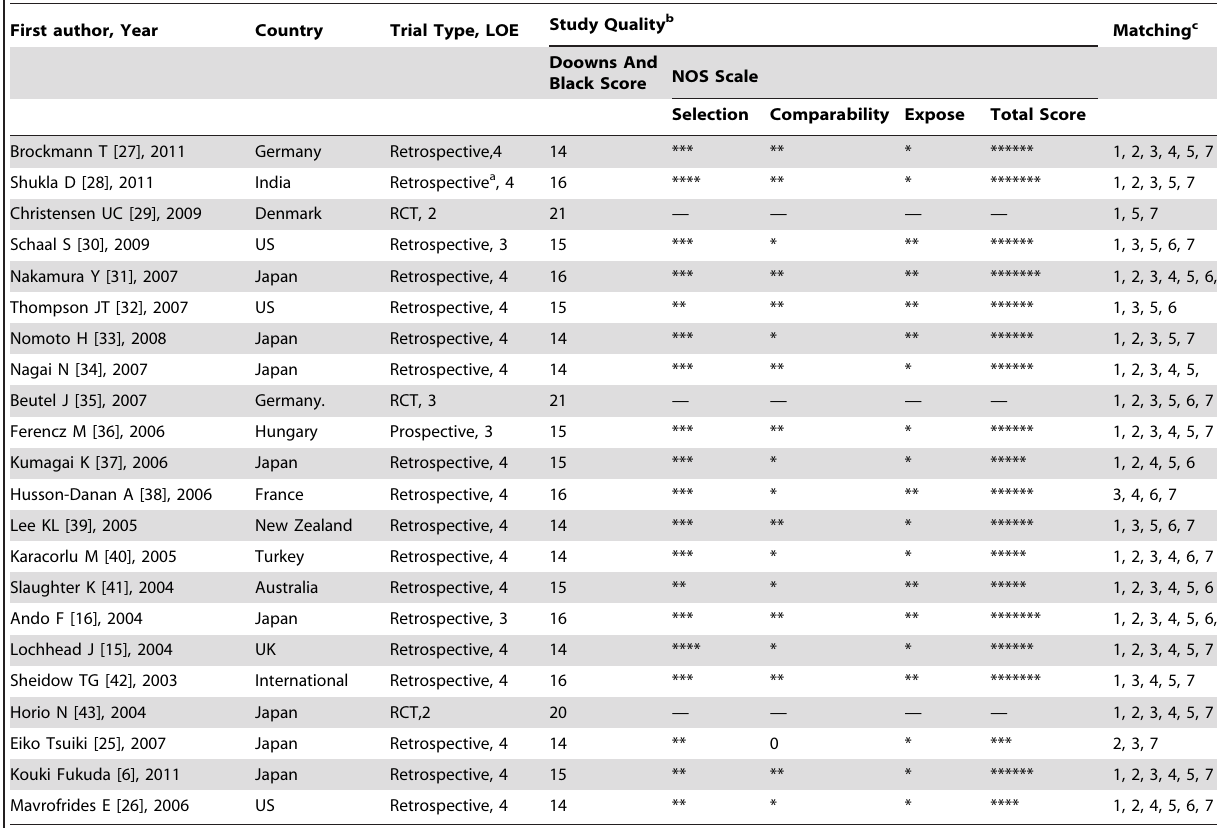
Table 1. Description of the characteristics of the included